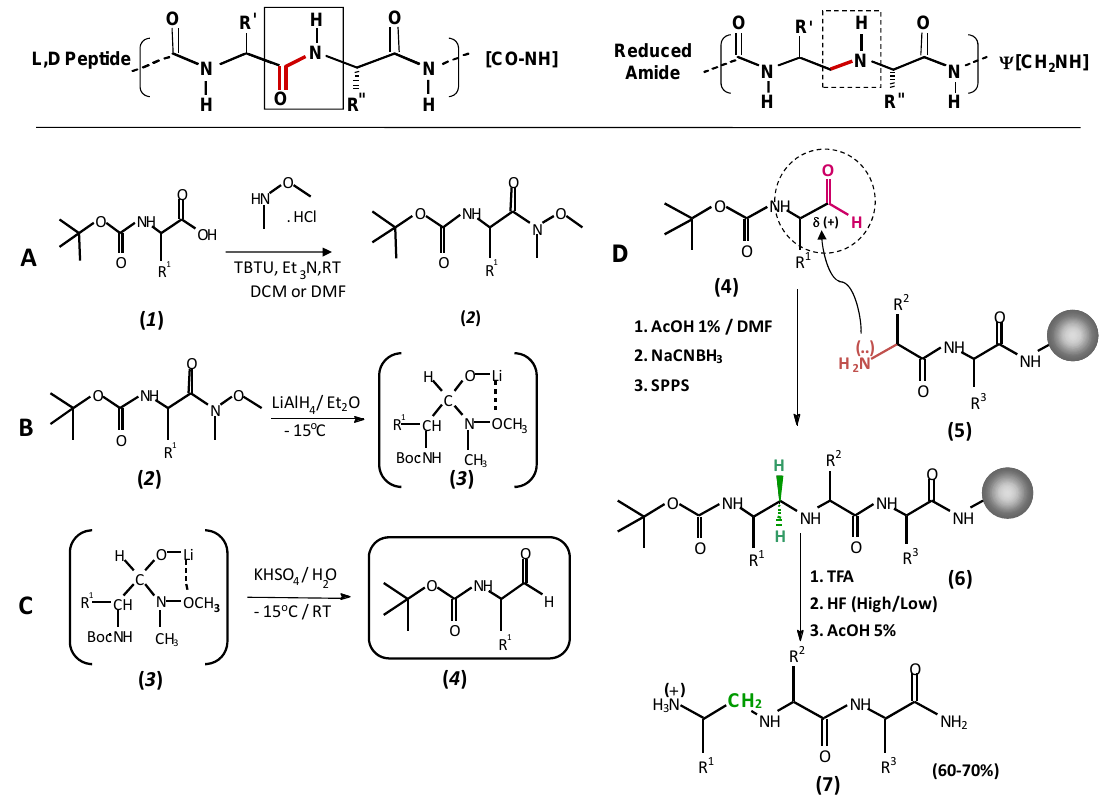
Scheme 2. Scheme of solid phase synthesis of reduced amide pseudopeptides. Peptide- bond isoster replacement -[CO-NH]- with  [CH -NH]. A. Chemical derivatization of an 2 alpha-aminoacid (1) to a carboxamide adduct (2). B. Treatment of the carboxamidated to produce a non-stable lithium five member ring (3). C. An acid product with LiAlH 4 treatment produces the target alpha-aminoaldehyde (4). D. Solid phase condensation of an alpha-aminoaldehyde (5) to a growing peptide chain (6) and its subsequent alkylative reduction to a methylene amine group